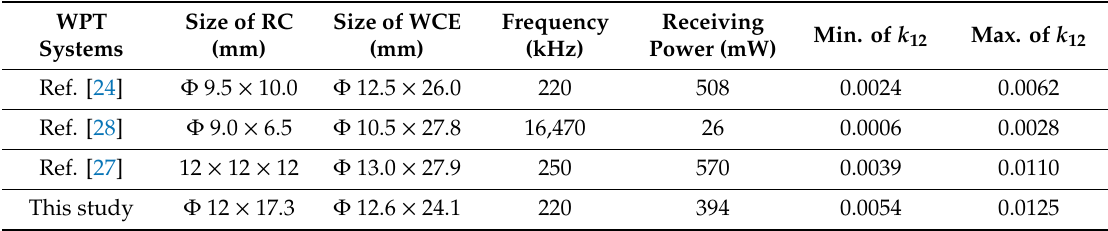
Table 3. Configuration, receiving power, and coupling coe ffi cient of the proposed and other wireless power transmissions